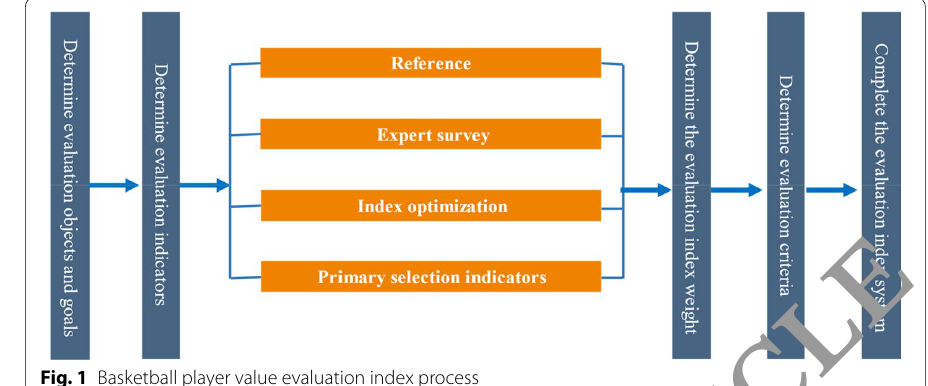
Fig. 1 Basketball player value evaluation index process